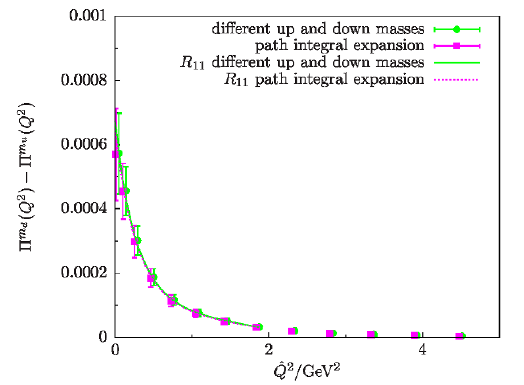
Figure 17 . Strong isospin correction to the HVP form factor. Green circles show results obtained using di(cid:11)erent masses for up and down quark. Purple squares show results using the path integral expansion. The solid green line and dashed purple line show results from a Pad(cid:19)e